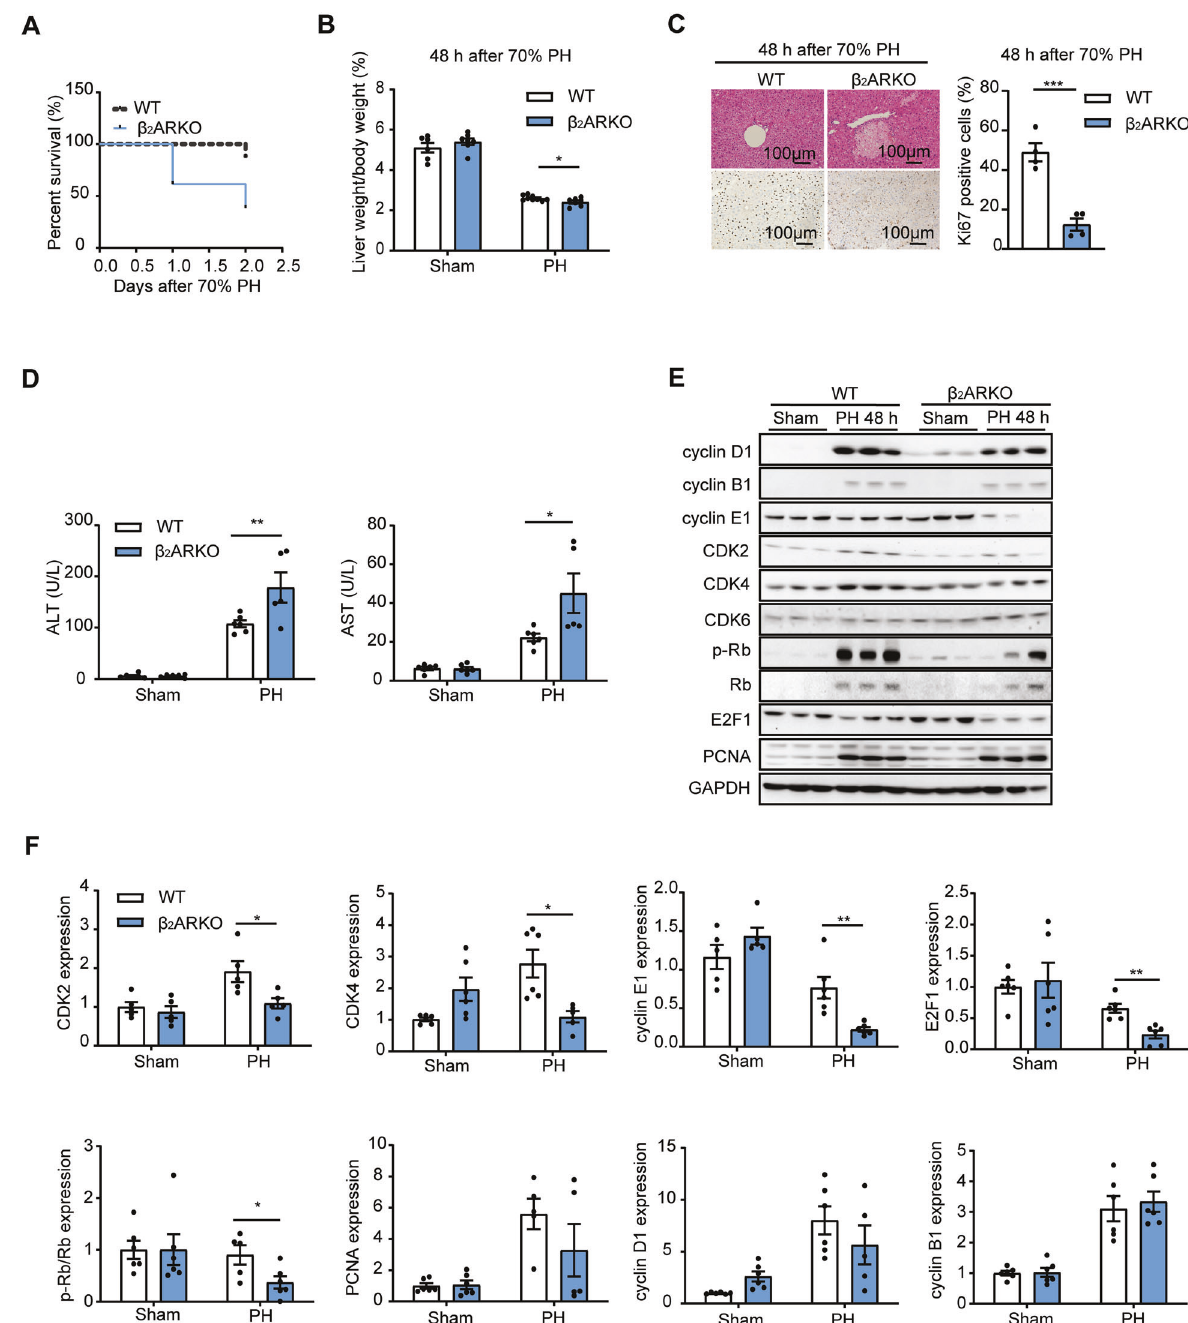
Fig. 3 β 2 AR de fi ciency impaired liver regeneration following 70% PH challenge. β 2 ARKO and WT mice were challenged with 70% PH, and the remaining livers were collected at the indicated times. The survival curve after PH of β 2 ARKO and WT mice ( A ) and liver weight to body weight ratio ( n = 6 – 9, B ). C HE staining (upper panel) and Ki67 (lower panel) staining of β 2 ARKO and WT mouse livers 48 h post PH. The percentage of Ki67-positive cells was measured ( n = 4). D The levels of ALT and AST in the serum of β 2 ARKO and WT mice 48 h post PH. E The protein levels of cell cycle markers in β 2 ARKO and WT mouse livers 48 h post PH ( n = 5 – 6). F Quantitative analysis of immunoblotting. Data are shown as means ± SEM. * P < 0.05, ** P < 0.01, *** P < 0.001 by two-tailed Student ’ s t